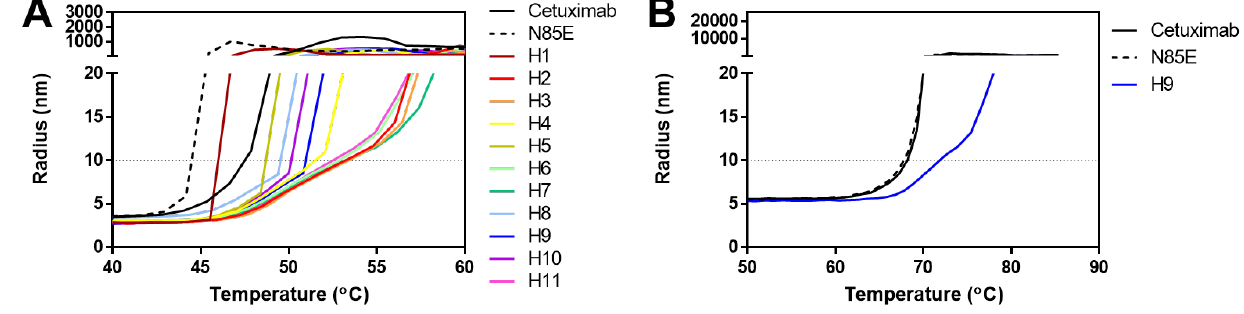
Figure 4 . Thermal stability of cetuximab-derived scFv-monoFc proteins ( A ) and mAbs ( B ), as determined by dynamic light scattering. Data are representative of two independent experiments. Unfolding temperatures (the point at which the radius surpassed 10 nm) are shown in Tables 2 and 3. N85E is aglycosylated cetuximab, whereas H1 through H11 are humanized variants.